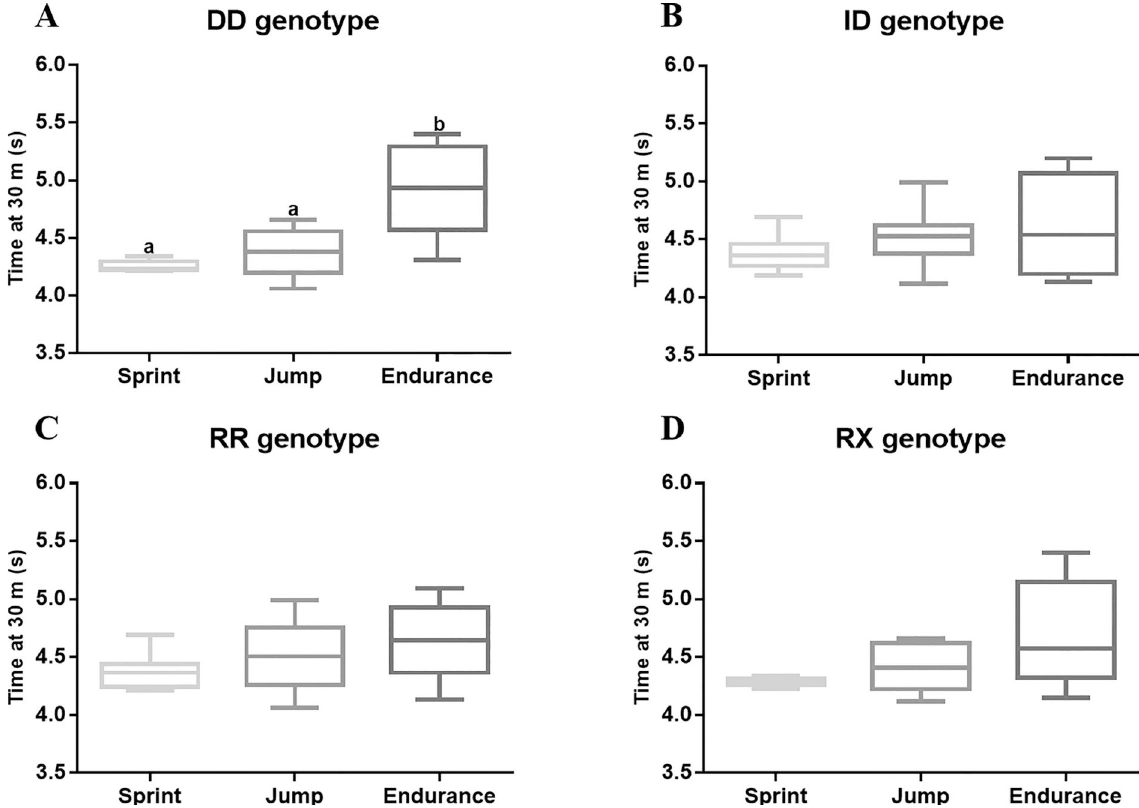
Figure 3 - Effect of ACE and ACTN3 gene variants on 30 m sprint in young talents. The DD genotype (a), ID genotype (b), RR genotype (c), and RX genotype (d). Different letters indicate significant differences between groups (one-way test (ANOVA) followed by Tukey's test, p <